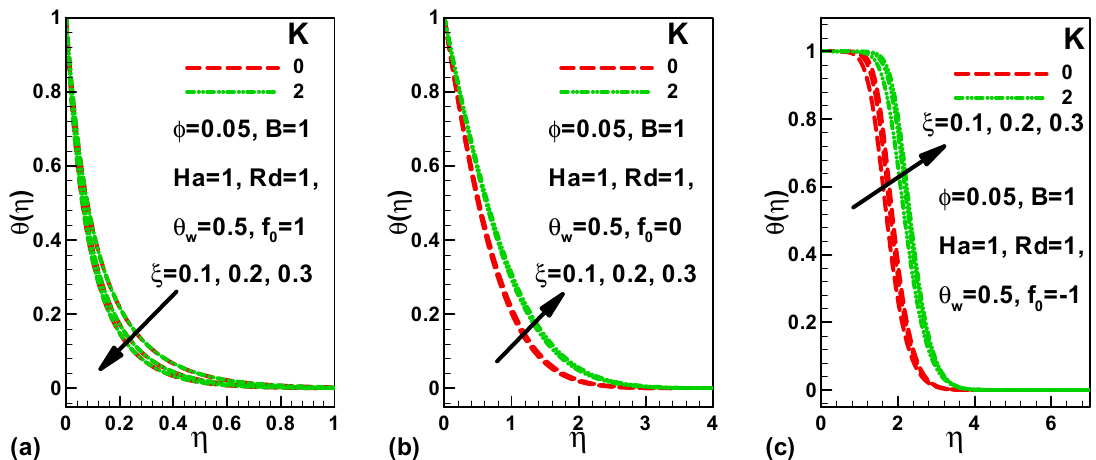
Figure 3. Effects of micropolar parameter on dimensionless temperature along truncated cone for ( a ) suction, ( b ) impermeable, and ( c ) injection of kerosene-based magnetite nanofluid.